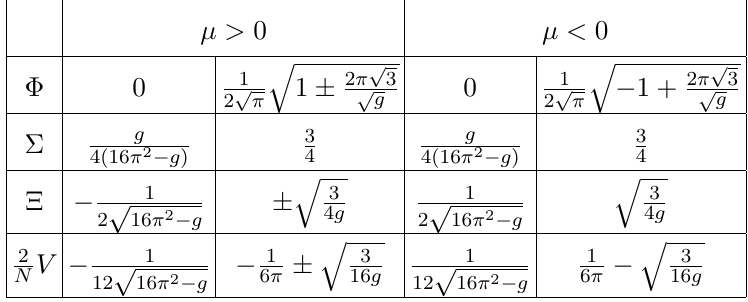
Figure 2 . The various solutions to the equations (2.19). The potential V is calculated from (2.20). is only a single ordered solution, and it exists only for g < 12 (cid:25) 2 . Note (cid:6) = 3 = 4